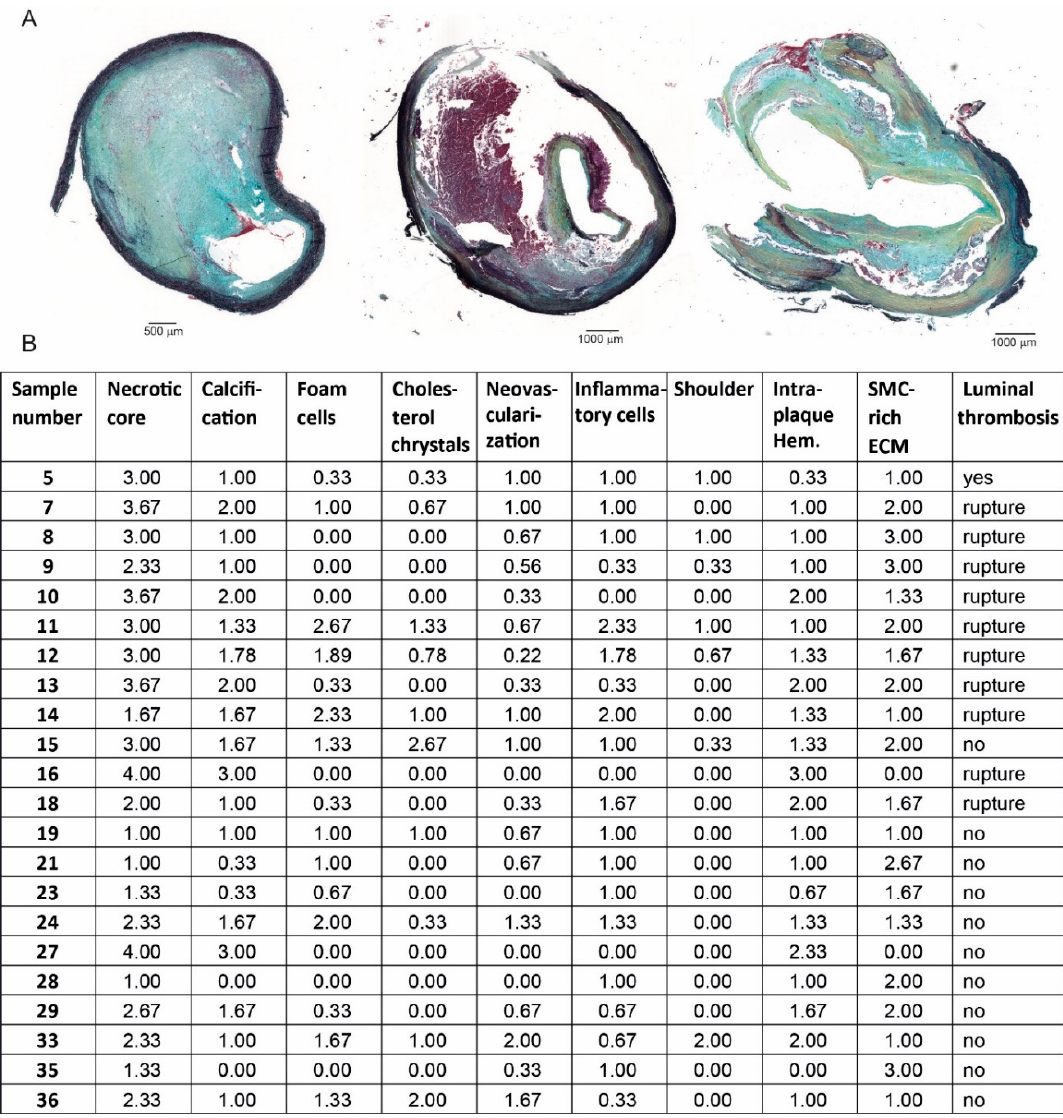
Figure 1. Human plaque characteristics. ( A ) Examples of Movat’s pentachrome stained human endarterectomy plaques. ( B ) Assessment of the plaque stability parameters of the individual plaques used for mast cell flow cytometry. SMC—smooth muscle cell; ECM—extracellular matrix.